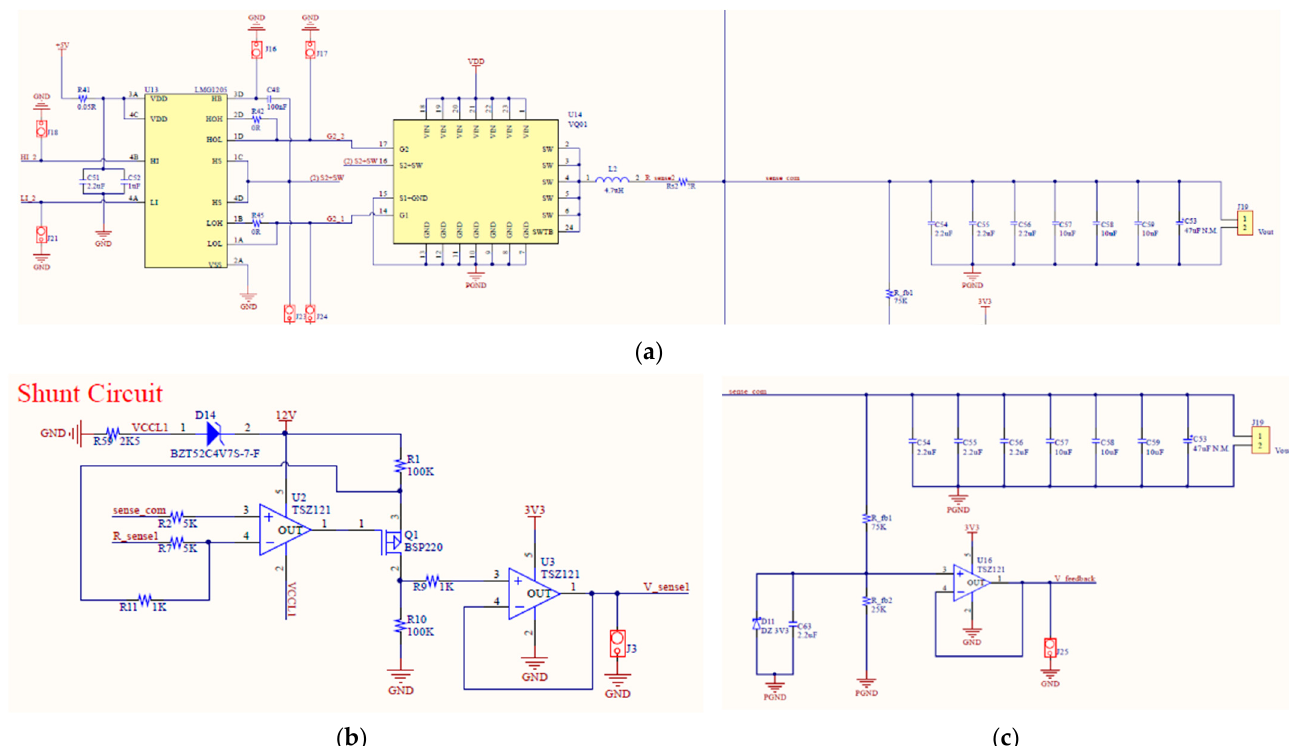
Figure 10. Converter blocks: ( a ) driving, power stage, inductor, shunt resistor, and output capacitors; ( b ) shunt resistor sensor circuit; ( c ) duty cycle regulation circuit. The switching behavior of the three phases system with the proper phase shift between each leg is shown in Figure 11.